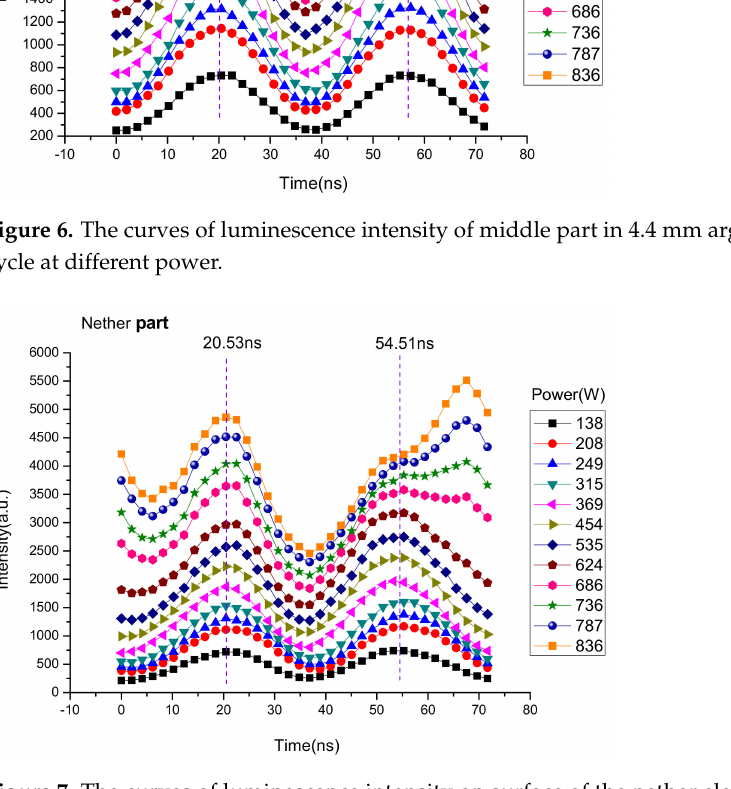
Figure 7. The curves of luminescence intensity on surface of the nether electrode in 4.4 mm argon DBD in one current cycle at different